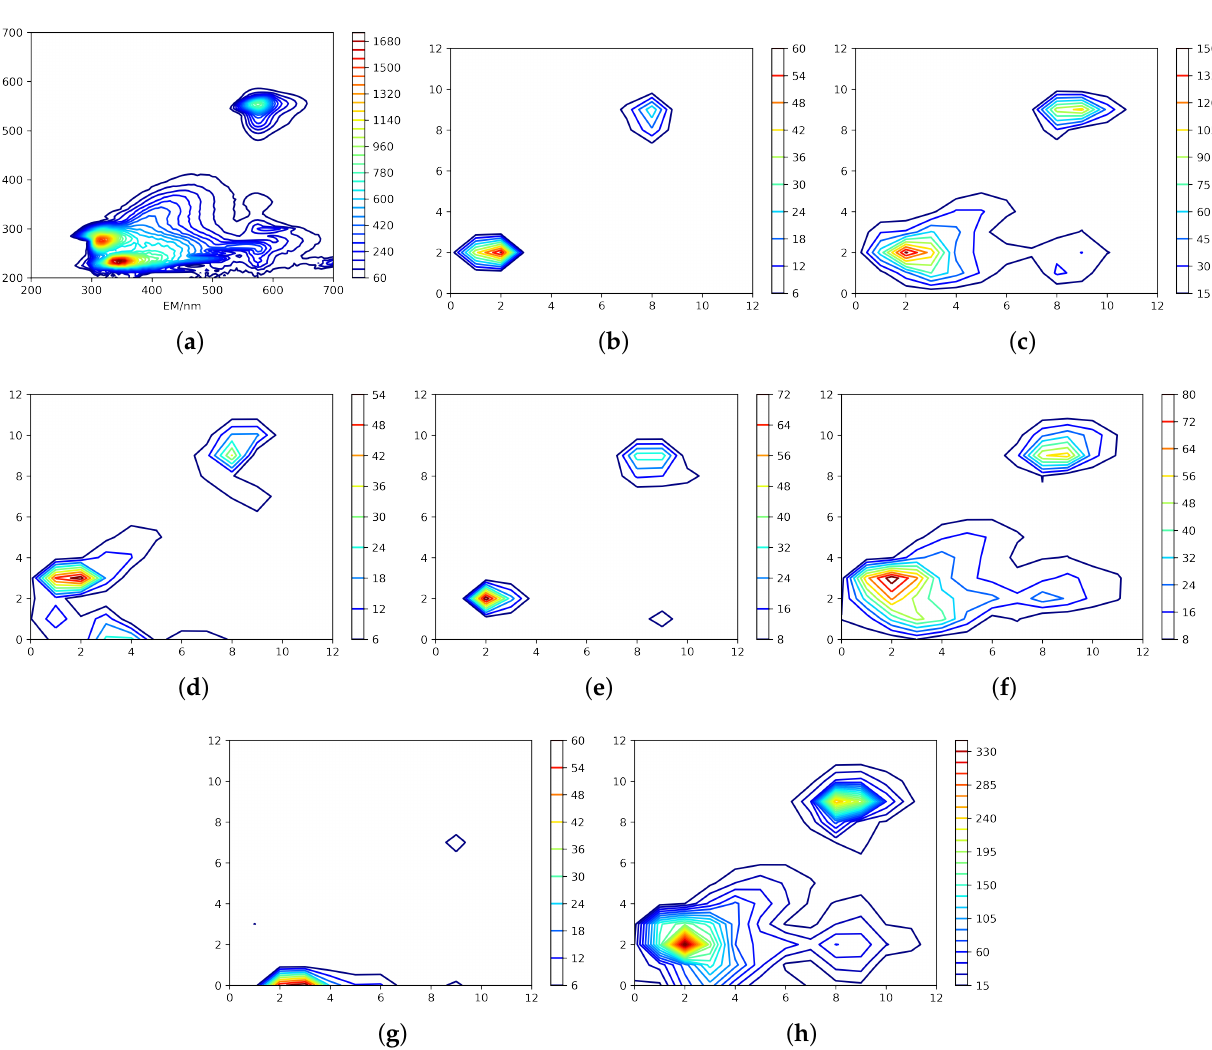
Figure 4. ( a ) Preprocessed EEM of rhodamin B in 20 µ g/L, and its feature spectra; ( b – g ) feature spectrum on channel 1–6; ( h ) superimposed spectrum on each